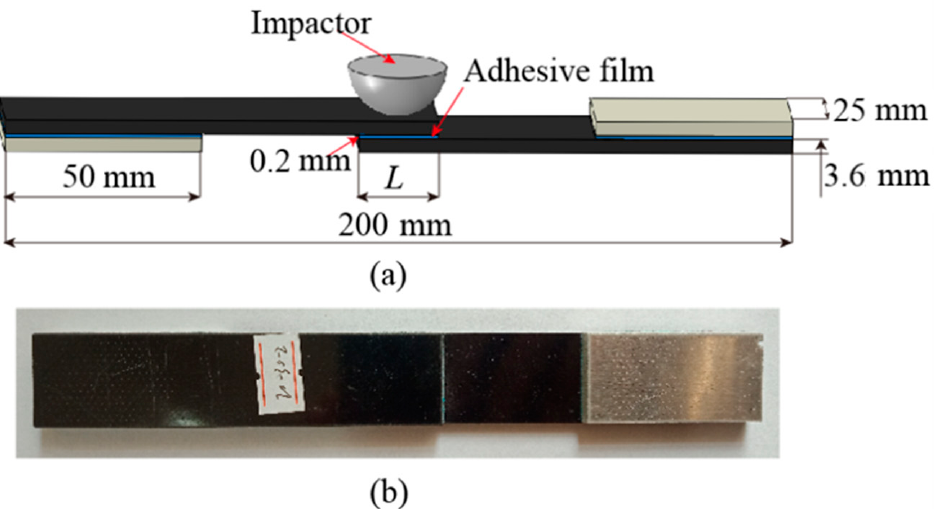
Figure 1. ( a ) Three-dimensional geometry of the single-lap joints (SLJs) (unit: mm) and ( b ) photo- graph of the specimen.